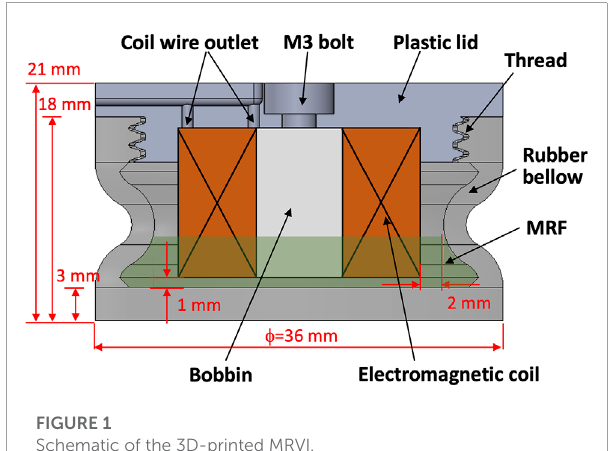
FIGURE 1 Schematic of the 3D-printed